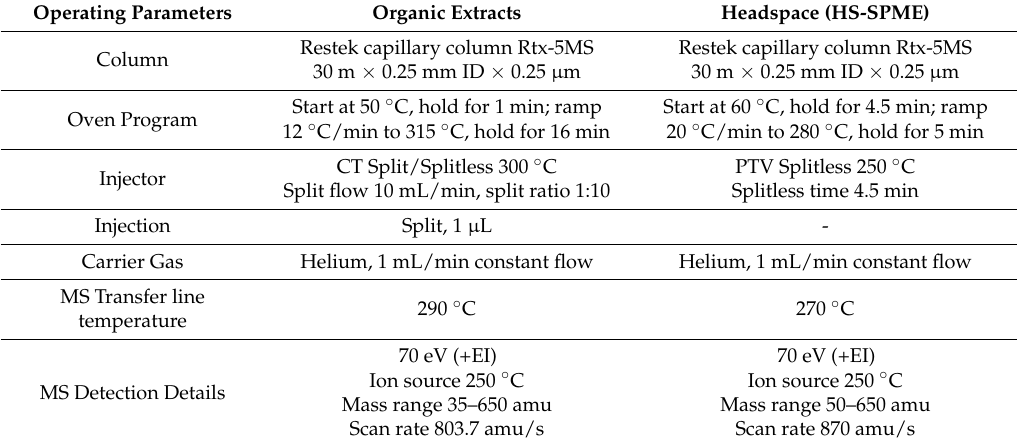
Table 3. Operating parameters of gas chromatography-mass spectrometry (GC/MS)